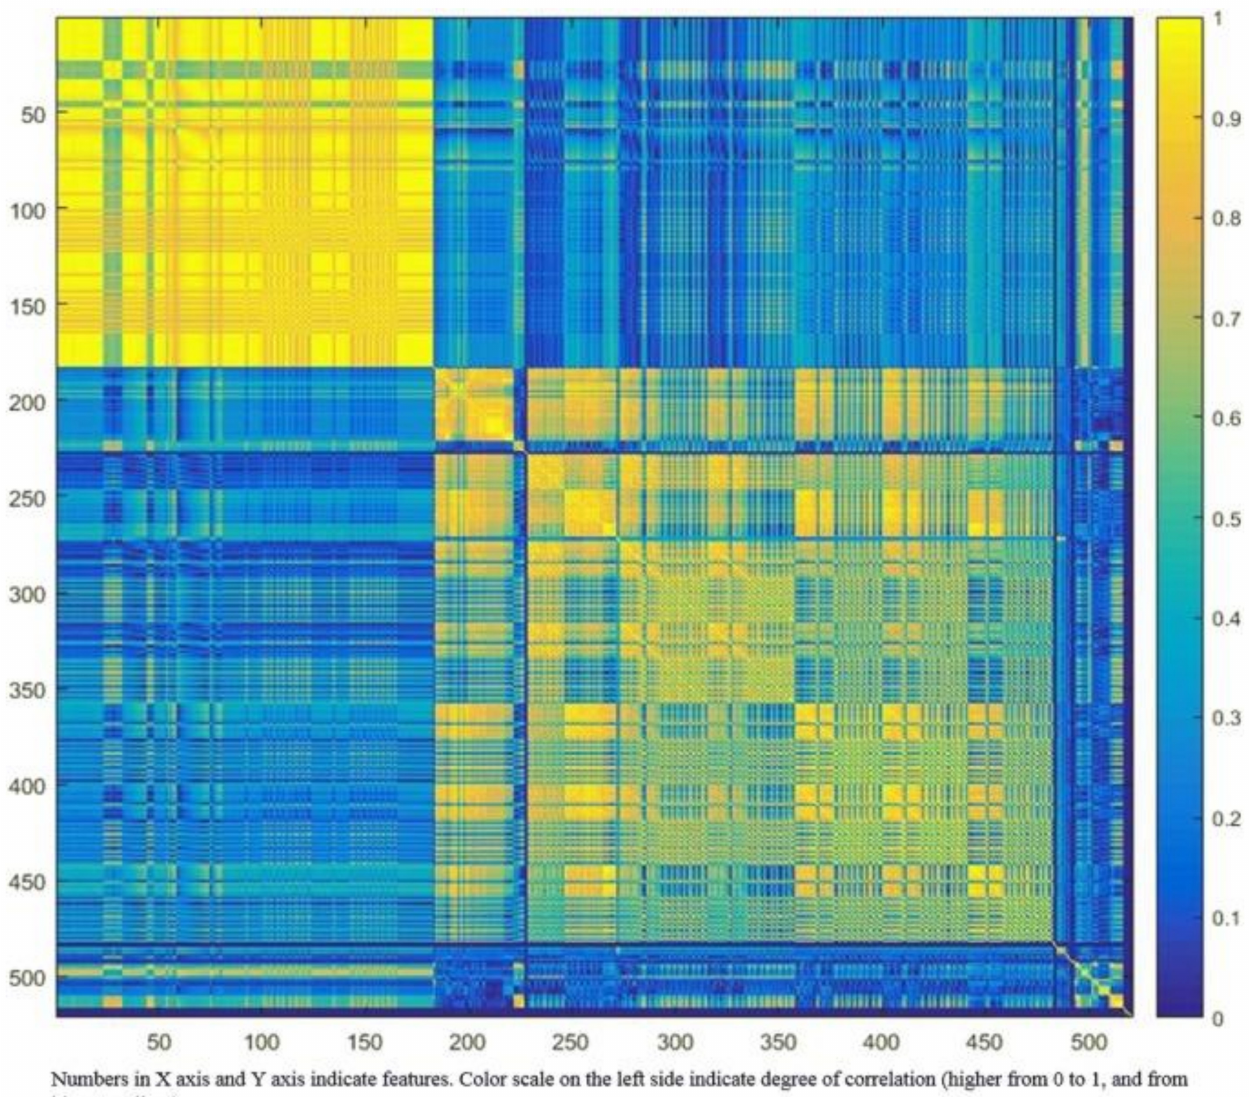
Figure 3. Graphic representation of radiomic feature clustering. Each radiomic feature was compared with all other features using linear regression analysis. Features were clustered based on the absolute values of the correlation coefficient of the corresponding regression models and plotted along both axes (ranging from 0 to 1 with greater values are shown in yellow with increasing intensity). In this example, the yellow blocks along the diagonal identify the clusters containing the highly correlated radiomic features. The first cluster in the top left corner demonstrated very high redundancy for radiomic features (represented by the high homogeneity of the yellow blocks). The blue blocks visualize the low correlation observed between the radiomic features. Adapted from Rizzo et al.